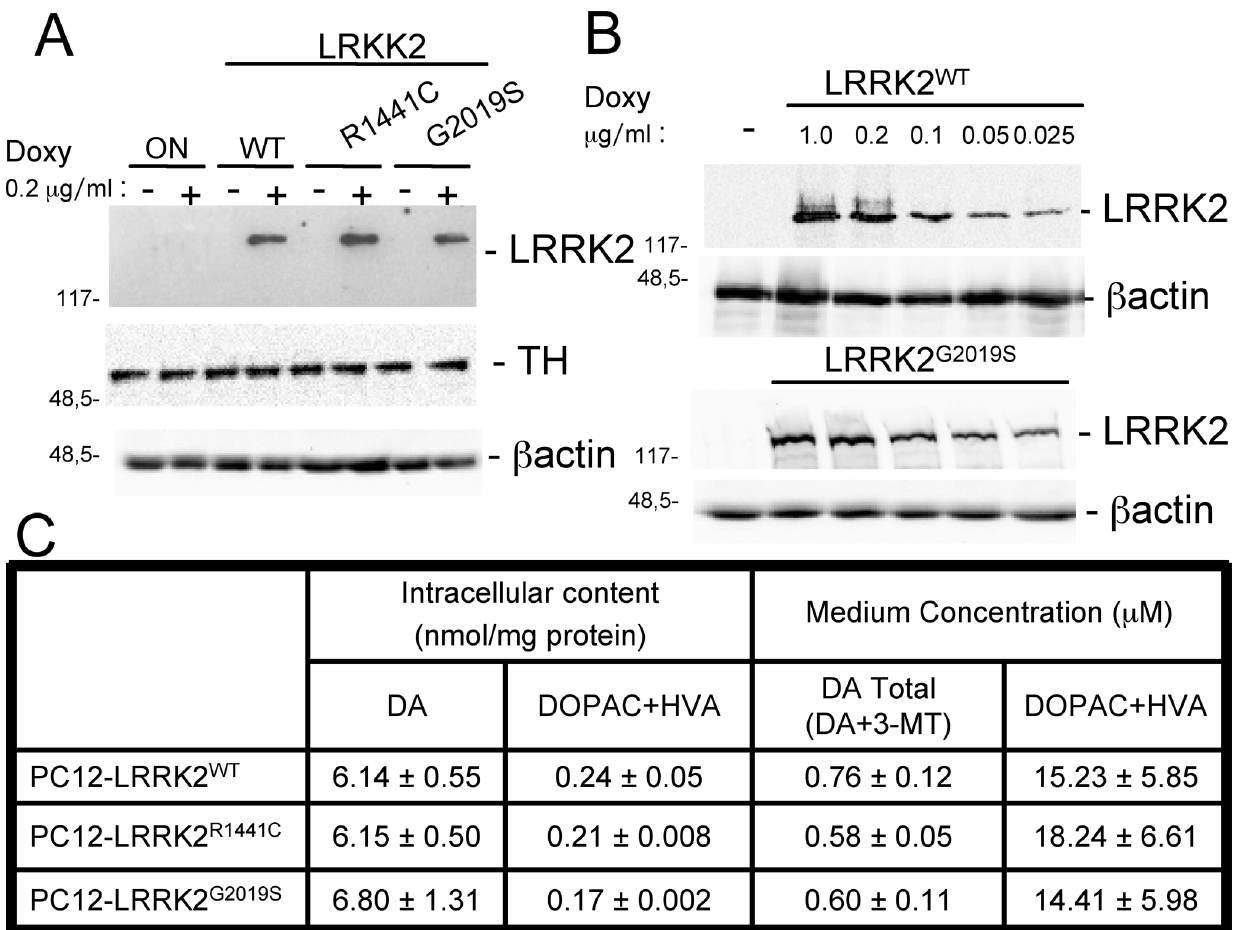
Figure 1. Characterization of PC12 cell expressing WT or mutant LRRK2. (A) PC12-derived cells expressing myc-tagged human WT or mutant-LRRK2 were left untreated ( 2 ) or treated ( + ) for 48 h with 0.2 m g/mL doxycycline to induce expression of transgenic LRRK2. Cell lysates were subjected to reducing SDS/PAGE. The anti-myc antibody was used to visualize LRRK2 and anti-TH for tyrosine hydroxylase. b -actin serves as controls for equal loading of samples. (B) Dose-dependent expression of doxycyline-inducible LRRK2 G2019S . Cells were treated for 48 h with the indicated concentration of doxycycline and equal amounts of protein were tested in Western blot analysis with anti-myc or anti- b -actin antibodies. (C) Effect of doxycycline on DA and DOPAC + HVA concentration in PC12 cell lysates and extracellular medium after 48 h expression. At the beginning of each experiment, 10 5 PC12 cells/cm 2 were plated and after the desired incubation period, the medium was aspirated from each well and stored, and the cells were collected in metaphosphoric acid. Samples were subsequently analyzed for levels of DA and its metabolites DOPAC and HVA in cell lysates and incubation medium. Results are the means 6 SEM of three experiments performed in triplicate.